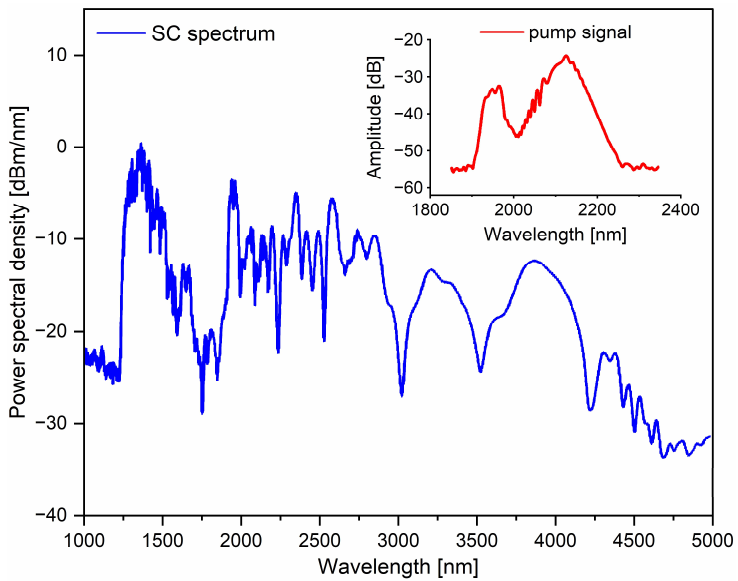
Figure 5. SC spectrum recorded for the average output power of 247 mW. Adopted with permission from [102]. Copyright 2015, Optica Publishing Group.